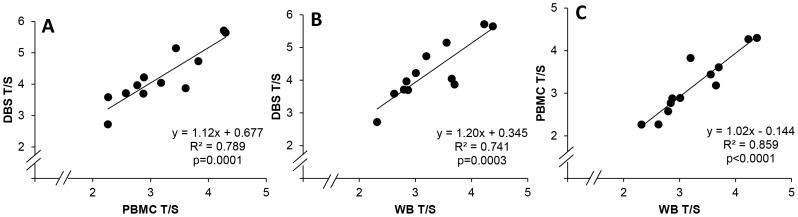
Comparison of T/S measurements in DBS, PBMC and WB samples.T/S ratios were determined for DNA from DBS (n = 12), PBMC (n = 12) and WB (n = 12) samples made from a single blood draw from 12 distinct individuals. Pearson’s R2 and p values are shown.